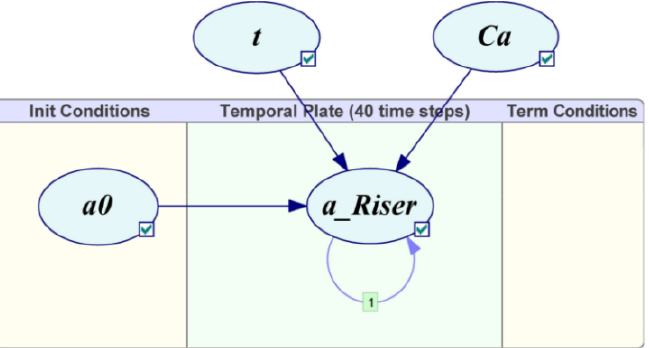
Figure 13. The BN model.